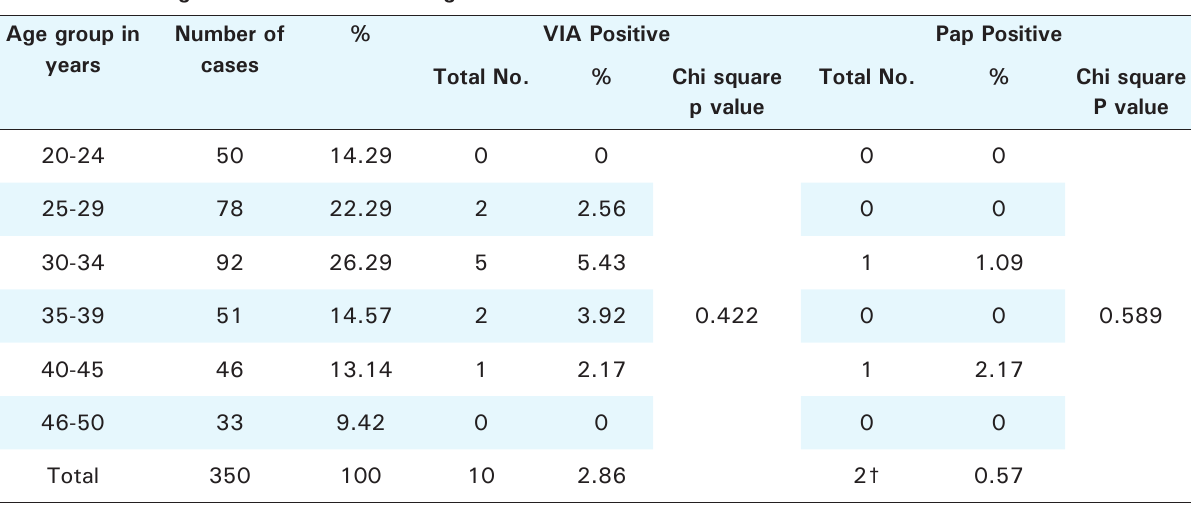
table 1. screening results in relation to Age distribution